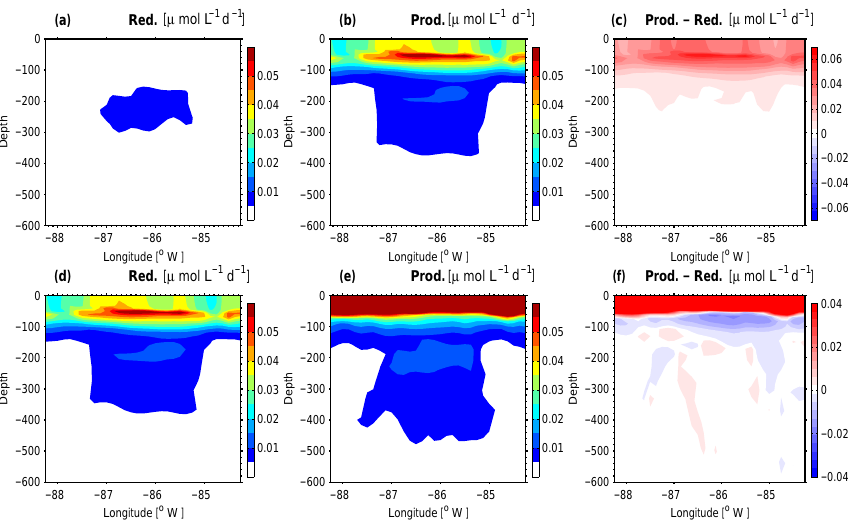
Figure 8. Eddy B sim vertical structure of (a) nitrate reduction by denitrification (µmolL − 1 d − 1 ), (b) nitrate production by nitrification (µmolL − 1 d − 1 ), (c) nitrate production-reduction difference (µmolL − 1 d − 1 ), (d) nitrite reduction (nitrification + denitrification + anammox, µmolL − 1 d − 1 ), (e) nitrite production (denitrification + nitrification, µmolL − 1 d − 1 ) and (f) nitrite production-reduction difference (µmolL − 1 d − 1 ) at the instant shown in Fig.